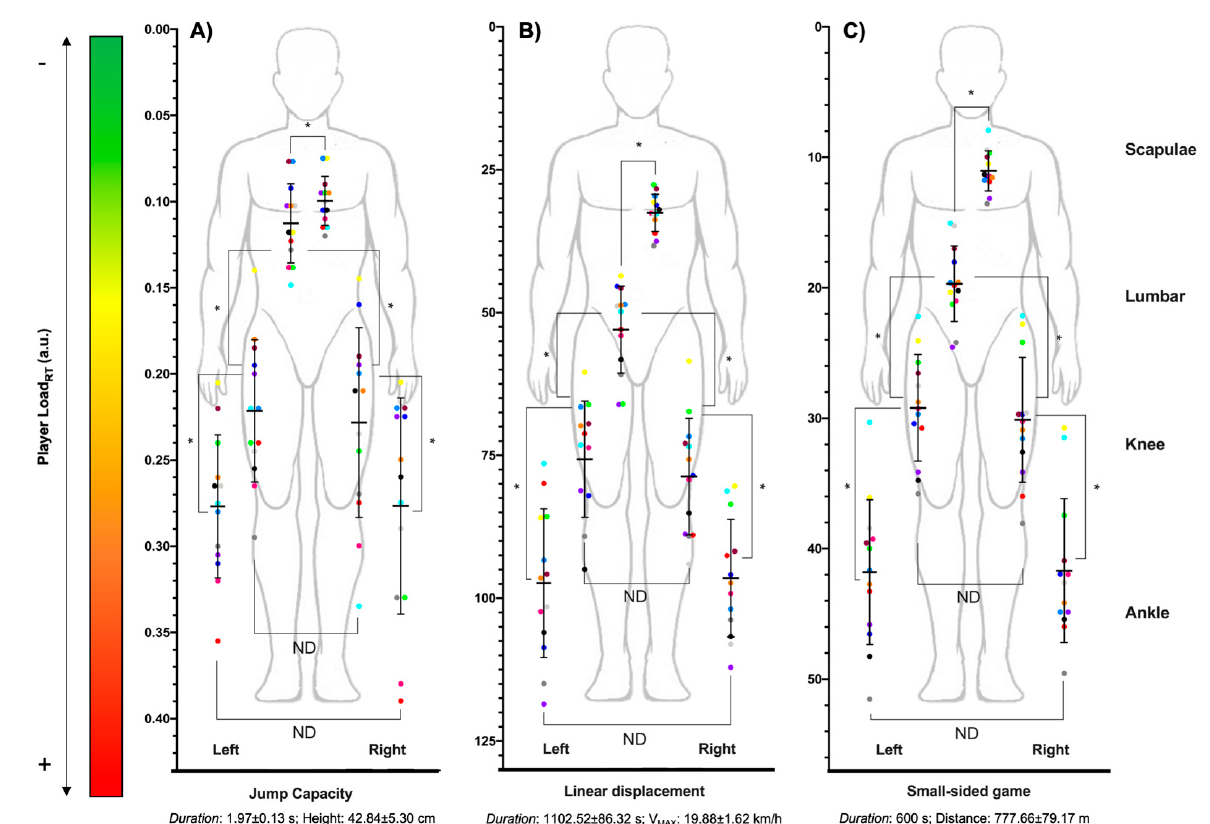
Figure 2. Scatter dots plot with mean (black line), whiskers (standard deviation) and dots (basketball players) to represent the multi-location external workload profile of semi-professional male basketball players in ( A ) jumps, ( B ) linear movements and ( C ) small-sided games. * Statistical differences ( p < 0.05); ND: no statistical differences.